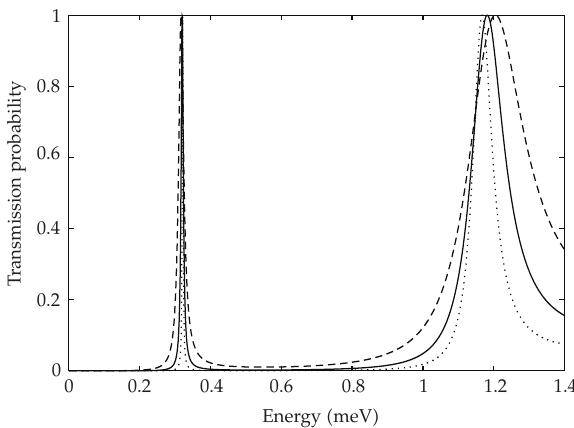
Figure 4: The calculated transmission probabilities for specific incident electron energies on a symmetric rectangular double barrier of height 1.4meV and separation 90nm with barrier widths 40nm (cid:9) dashed (cid:10) , 50nm (cid:9) solid (cid:10) , and 60nm (cid:9) dotted (cid:10) . Values were calculated analytically for an isolated ballistic elec- tron.